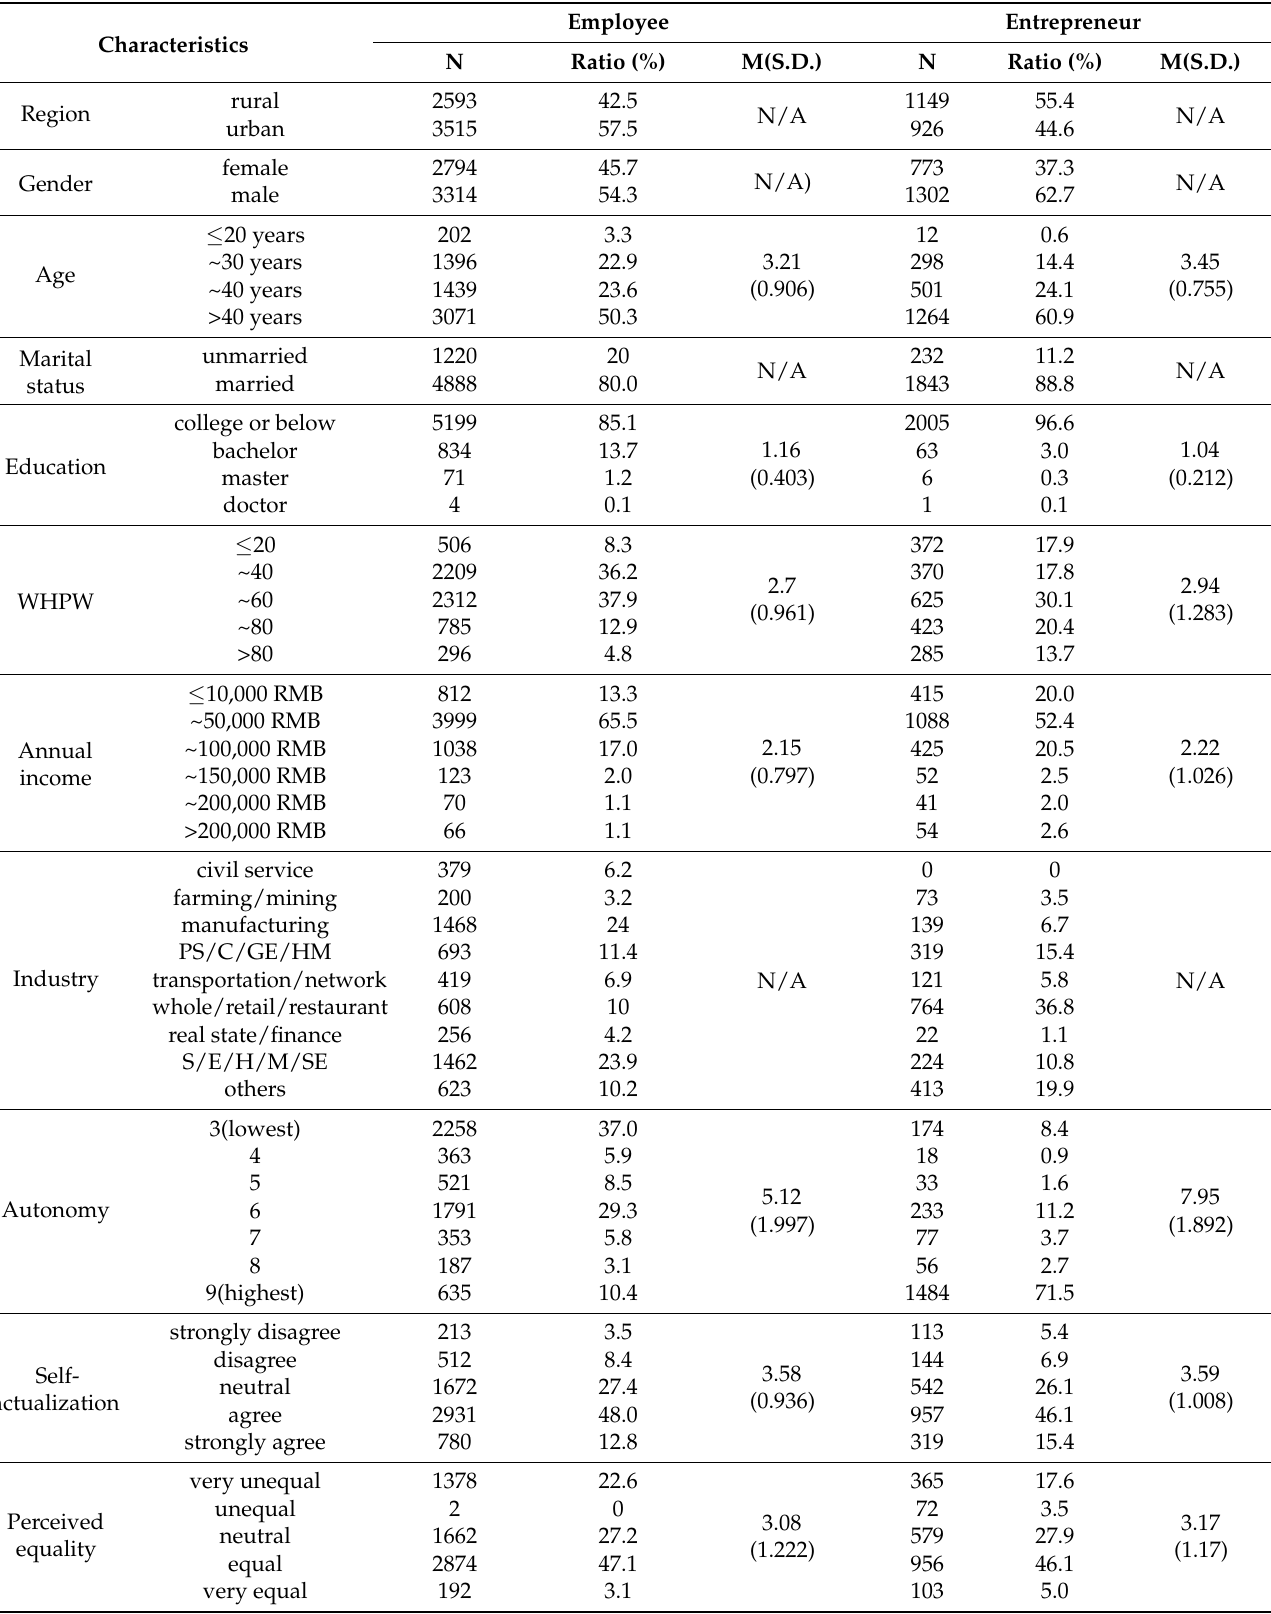
Table 2. Characteristics of the employee and entrepreneur